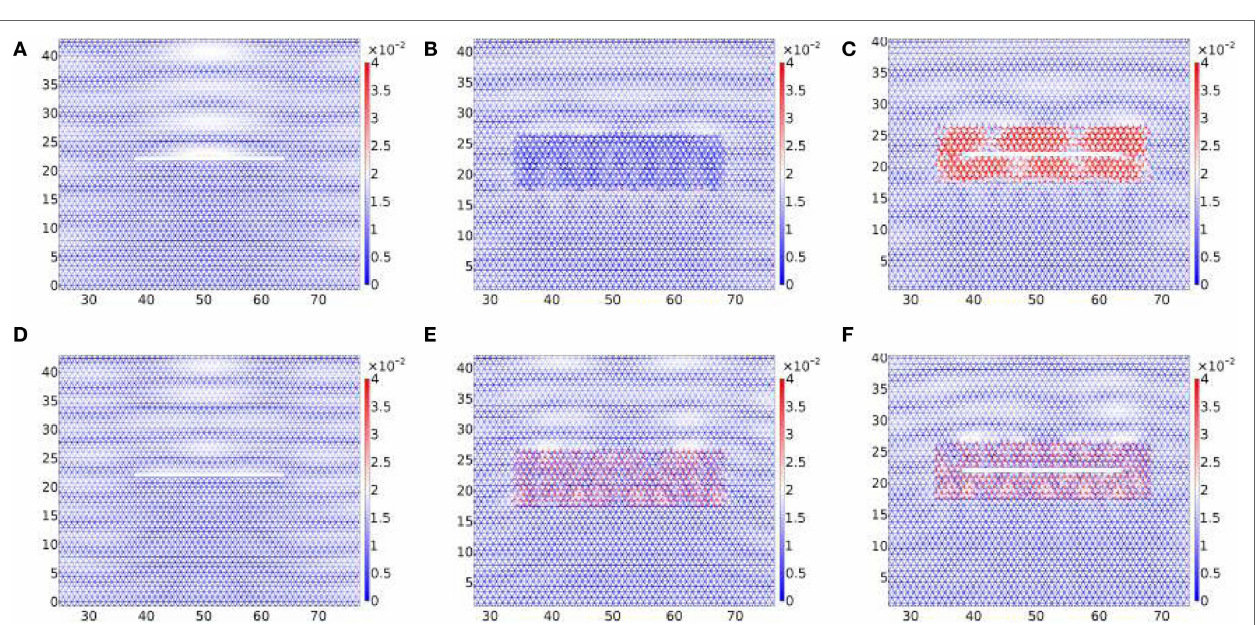
Frontiers in Materials |